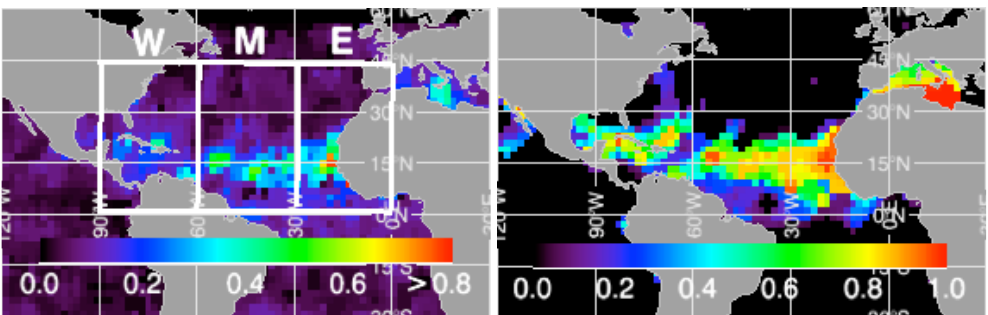
Fig. 1. Location of the 3 North-Atlantic regions examined in this study. Colors indicate the nighttime CALIOP Aerosol Optical Depth (AOD) contributed from all aerosols (left), and fraction percentage of the dust contribution to AOD (right) over oceans for the 7 June–7 July 2007 period, at a pixel resolution of 2 ◦ × 2 ◦